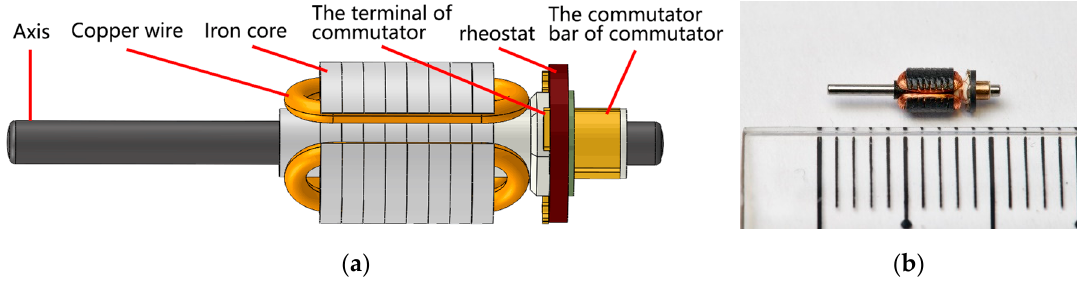
Figure 1. ( a ) The model of armature and ( b ) the real sample.